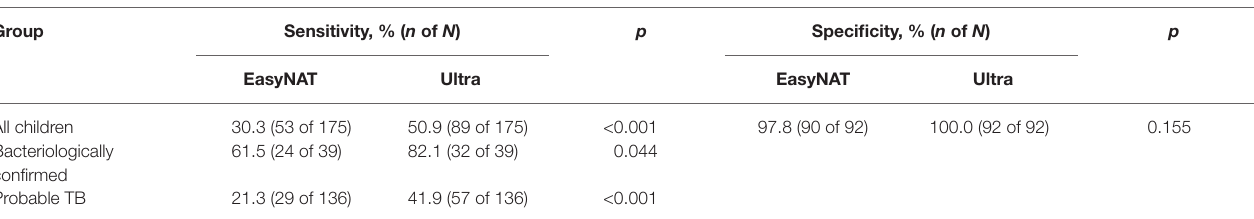
TABLE 3 | Comparison of EasyNAT and Xpert ultra in children with TB and RTIs.